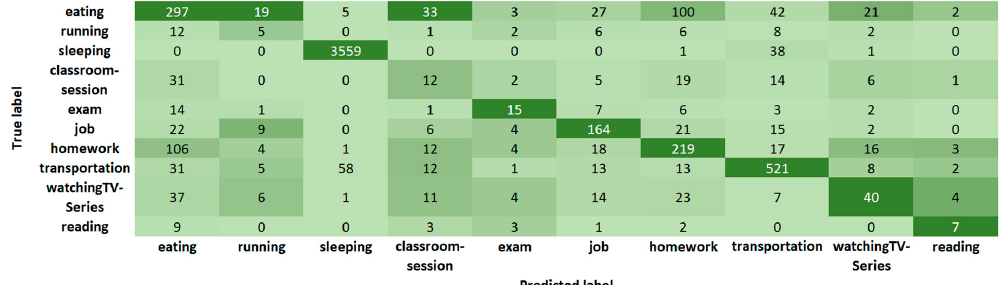
Figure 4. Confusion matrix for daily-activity classification with Random Forest.